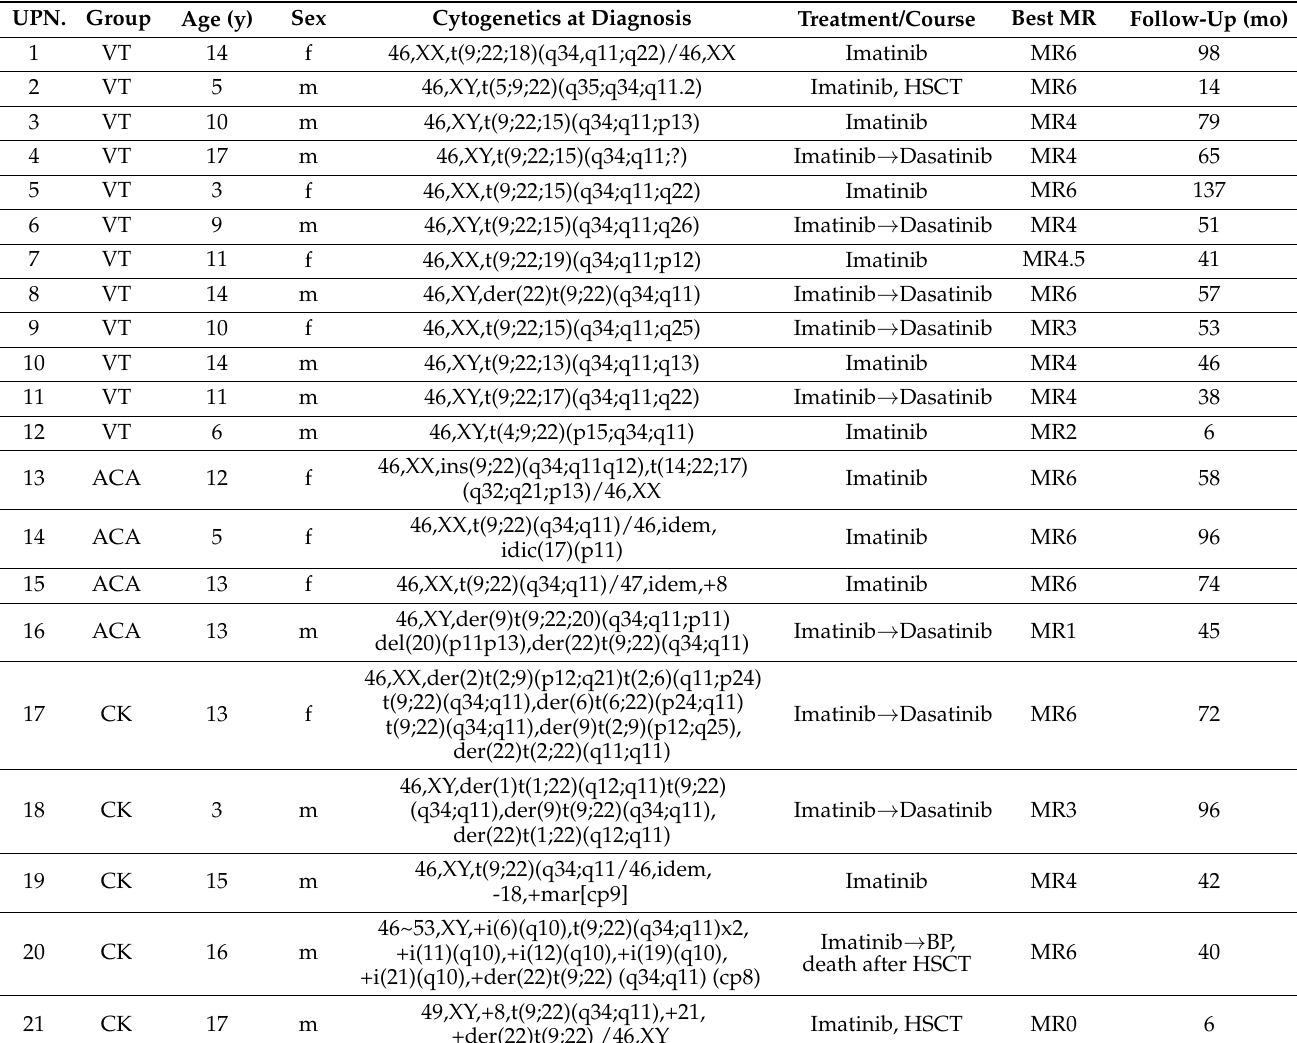
Table 2. Individual characteristics of n = 21 patients with variant translocations (VT), additional chromosomal aberrations (ACA) and complex karyotype (CK). A minimum of 15 metaphases were analyzed in each